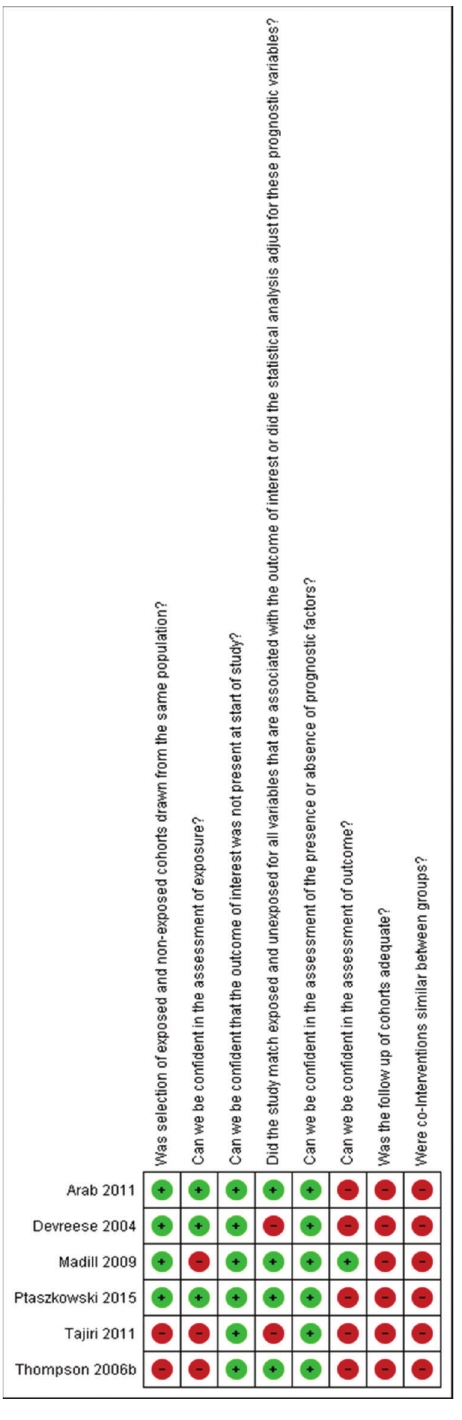
Figure 2 - Risk of bias assessment. We considered ‘‘ probably high risk of bias ’’ as ‘‘ definitely high risk of bias ’’ (red color) and ‘‘ probably low risk of bias ’’ as ‘‘ definitely low risk of bias ’’ (green